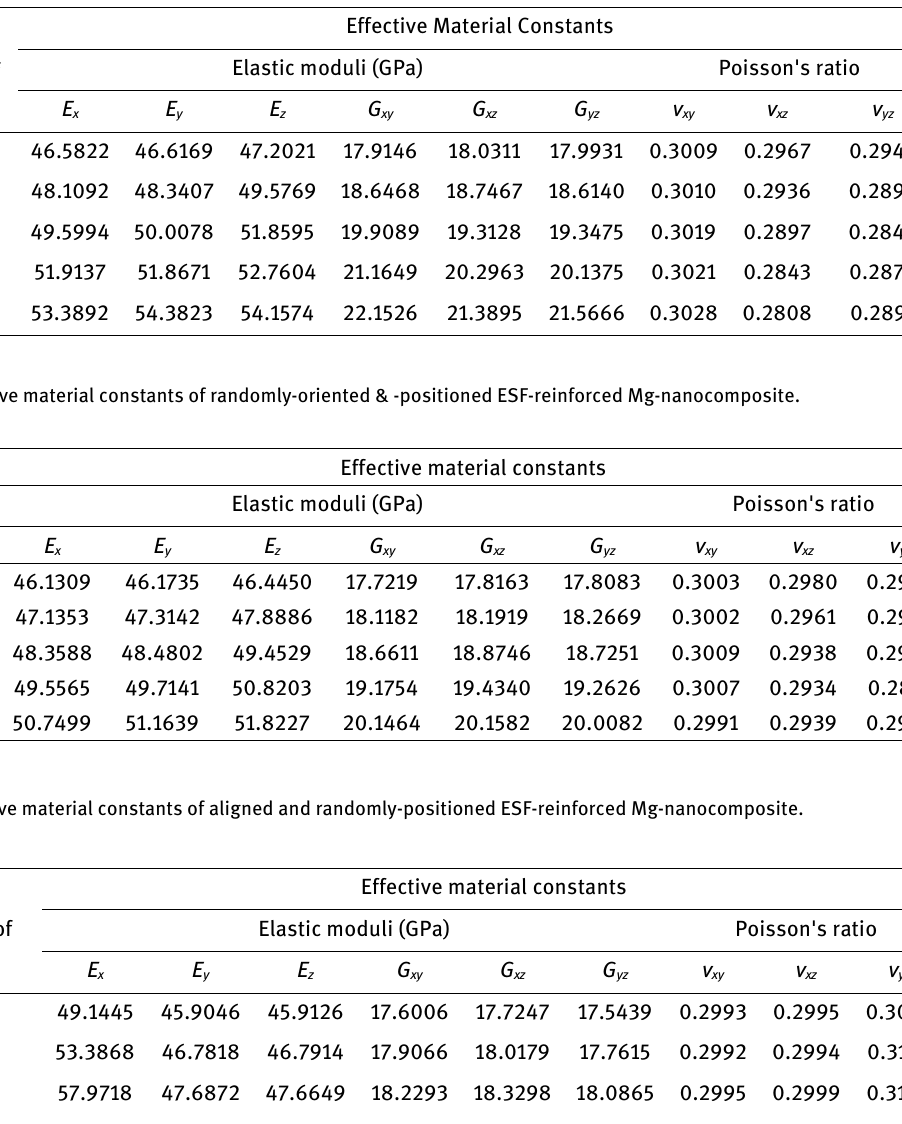
Table 3: Effective material constants of randomly-oriented & -positioned CNT-reinforced Mg-nanocomposites (i.e., without interphase ef- fect).